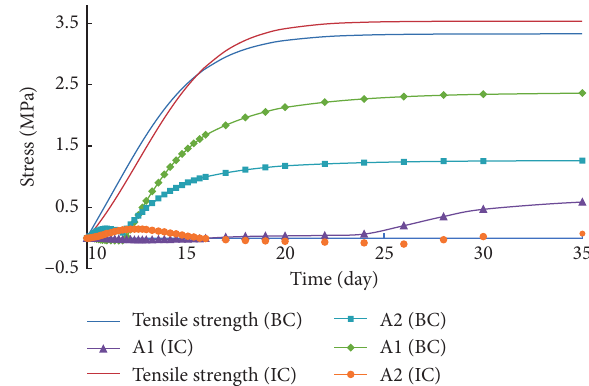
Figure 9: Change curve of principal stress with age at key points of